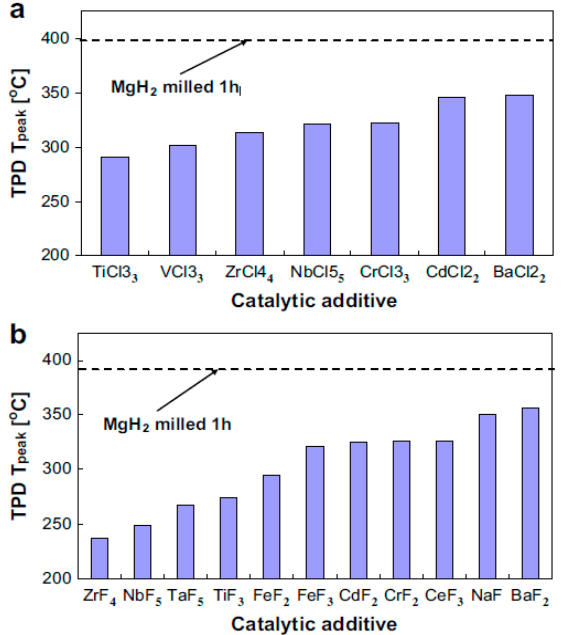
Figure 3. Maximum temperature of MgH 2 decomposition TPD. peak (T peak) catalyzed by 7 wt% of various halide additives:( a ) chlorides and ( b ) fluorides [134].